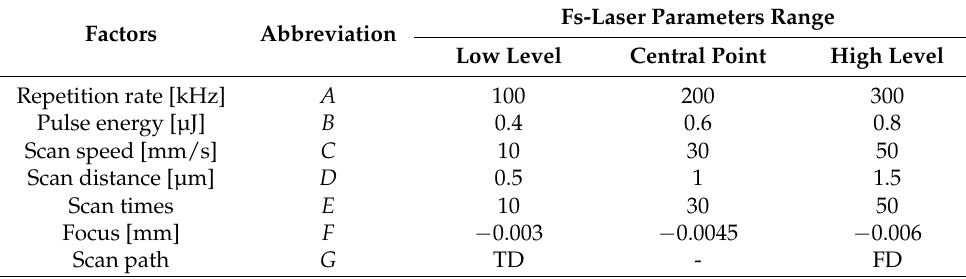
Table 1. Control factors and levels adopted in milling tests.